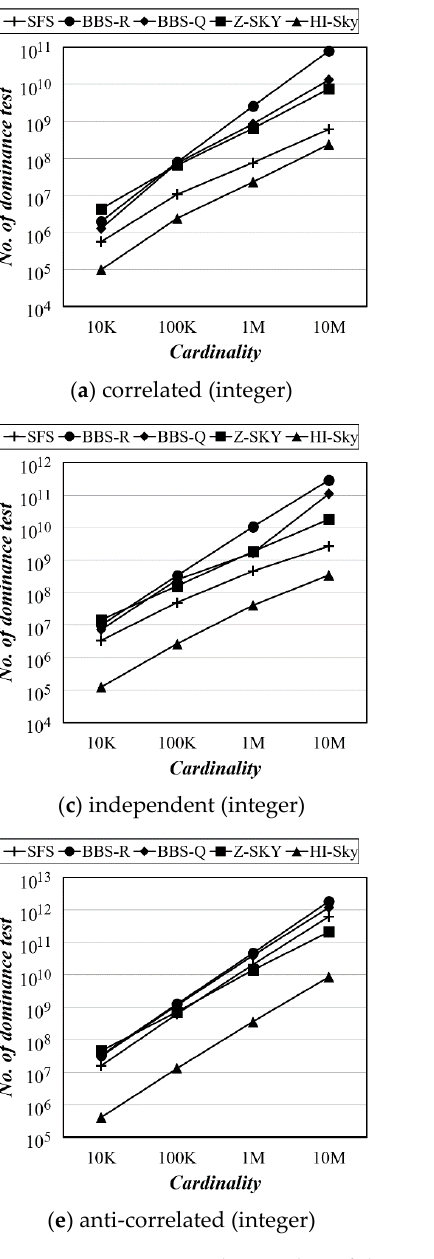
Figure 11. The number of dominance tests according to cardinality.